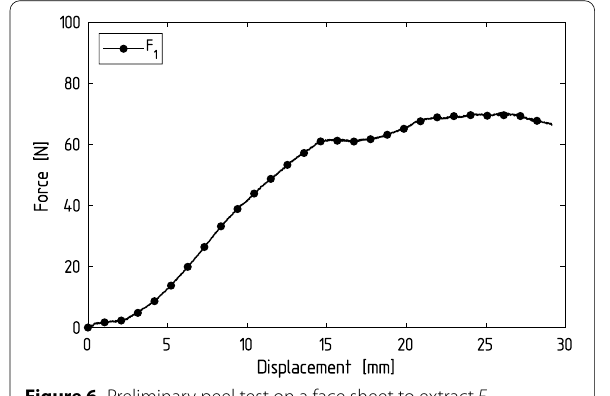
Figure 6 Preliminary peel test on a face sheet to extract F 1